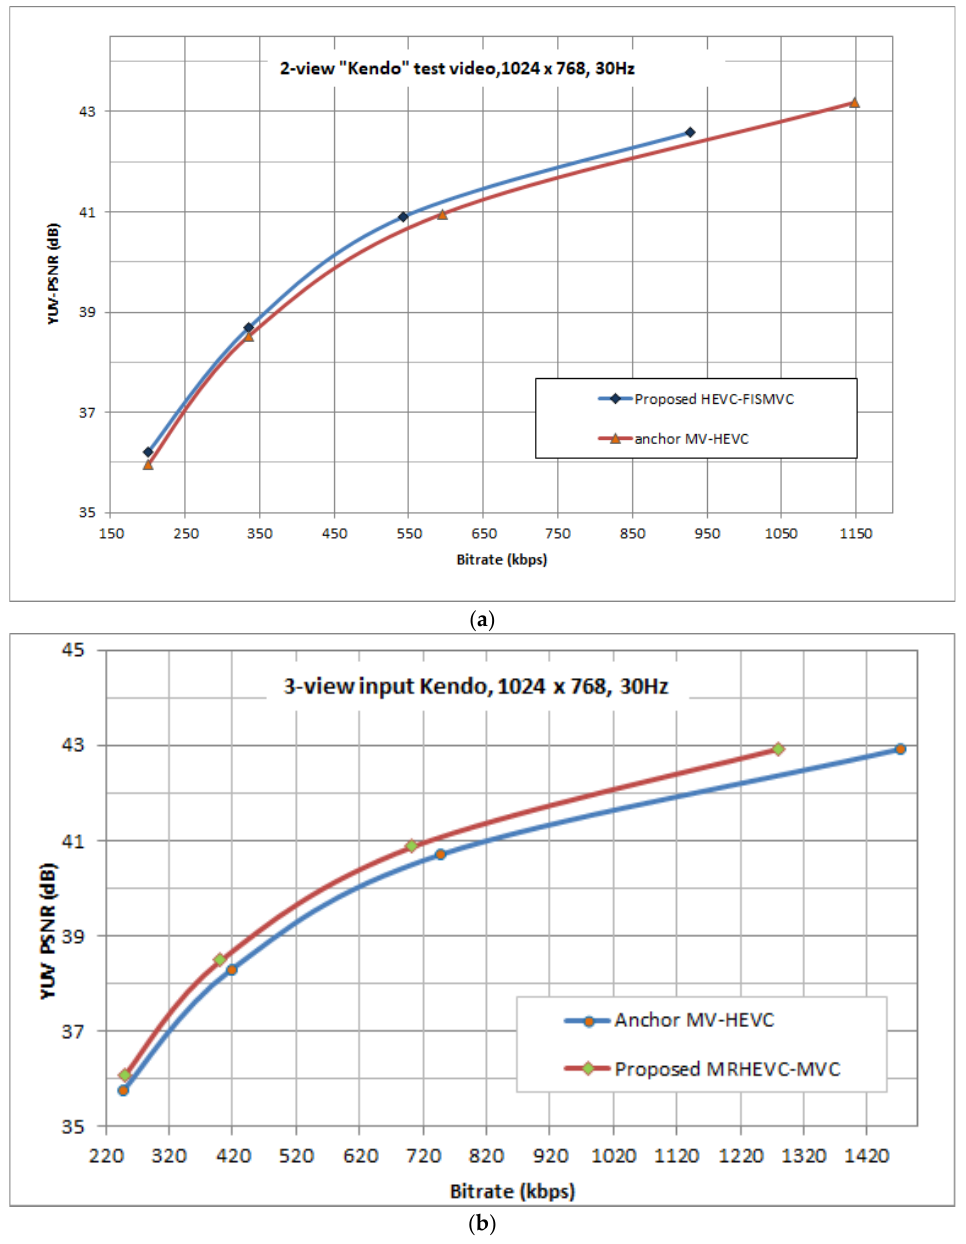
Figure 5. Average YUV-PSNR vs bitrate of the anchor MV-HEVC and the proposed HEVC-FISMVC codecs for coding: ( a ) 2- view “Kendo” multiview videos and ( b ) 3- view “Kendo” multiview videos.